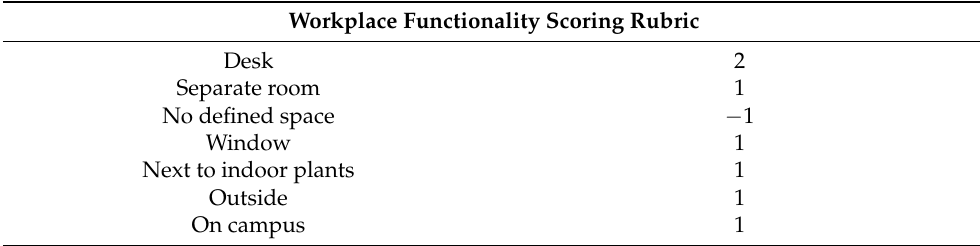
Table A2. Workplace functionality rubric for survey answers. Participants were told to select all that applied, and scores were cumulative based on their